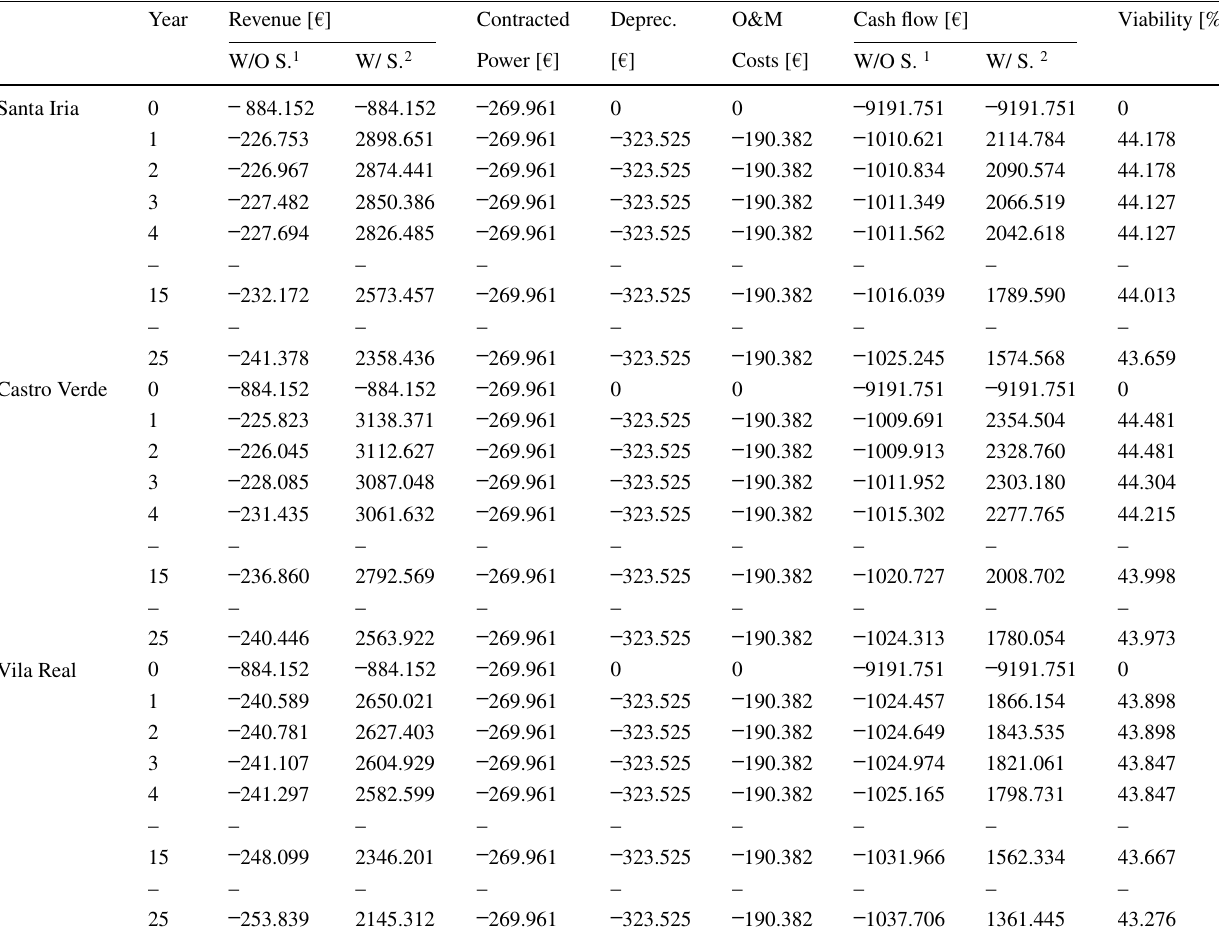
Table 8 c-Si: Initial Investment = 8088.118 €: 1 Without selling the surplus energy to the grid; 2 With selling the surplus energy to the